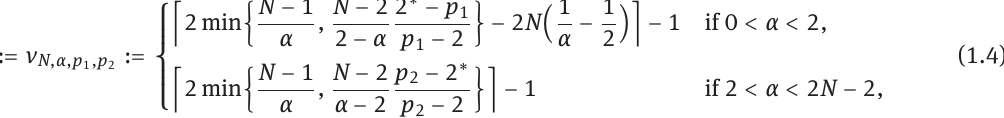
Figure 3: ν as a function of p 2 > p ∗ α ∈ ( 2, 2 N − 2 )